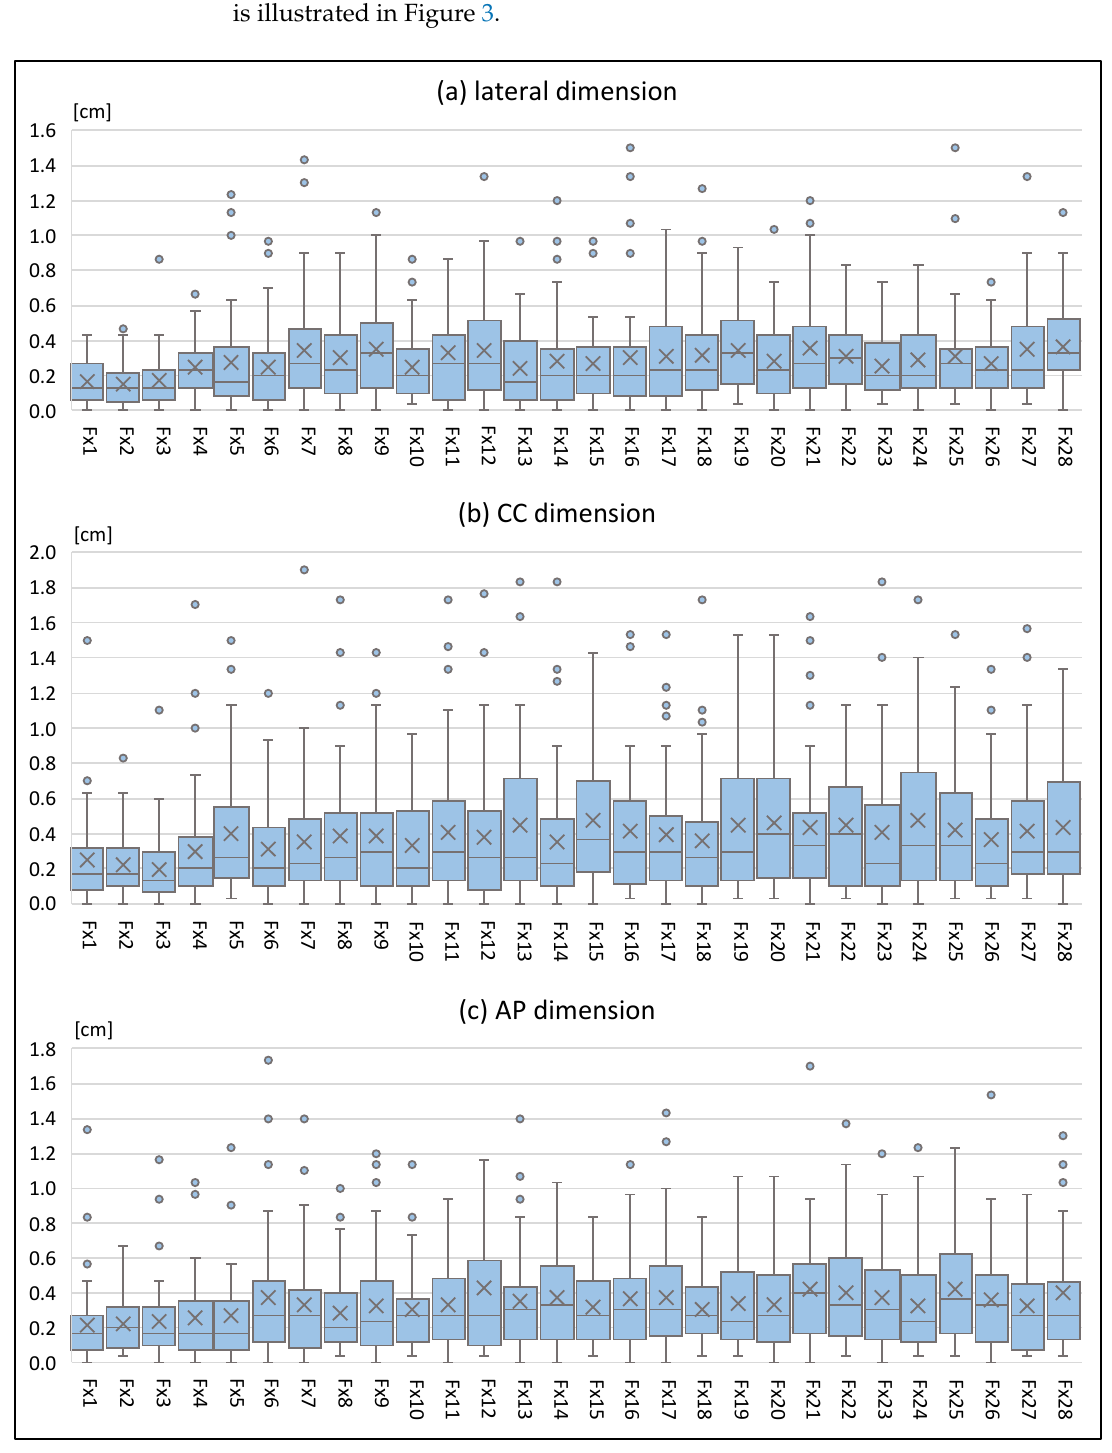
Figure 2. Setup errors in lateral ( a ), CC ( b ) and AP ( c ) dimension during treatment.